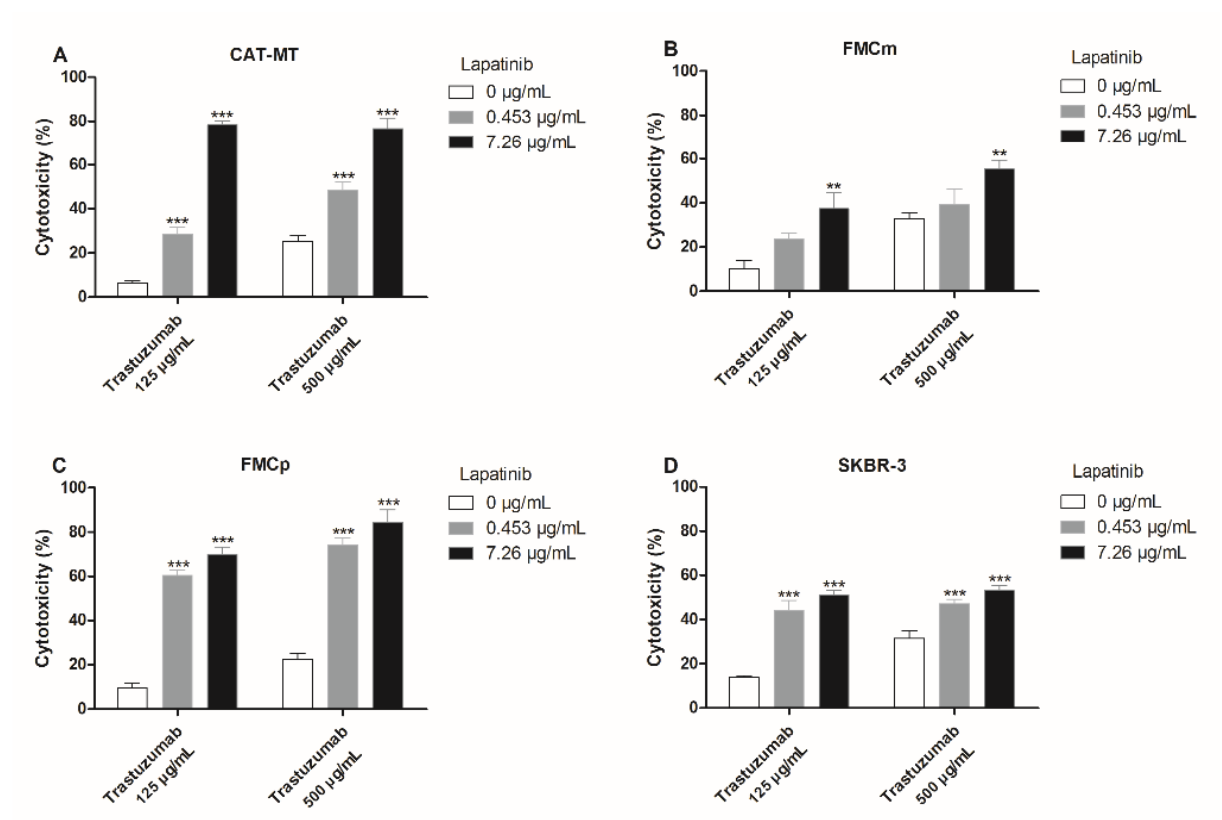
Figure 5. Combined treatments with trastuzumab plus lapatinib allowed to obtain a valuable synergistic antiproliferative effect in the carcinoma cell lines. ( A ) CAT-MT and ( C ) FMCp cells presented a significant increase in the cytotoxicity for all the concentrations tested (*** p < 0.001). ( B ) FMCm cells presented the highest increase in the cytotoxic effect by the combination trastuzumab at 125 µ g/mL plus lapatinib at 7.26 µ g/mL, being possible to achieve 37.4% of cytotoxicity (** p < 0.01). ( D ) In the human SKBR-3 cell line, all the combinations presented a synergistic antiproliferative effect (*** p < 0.001). The experiments were performed in triplicates and repeated three separated times.